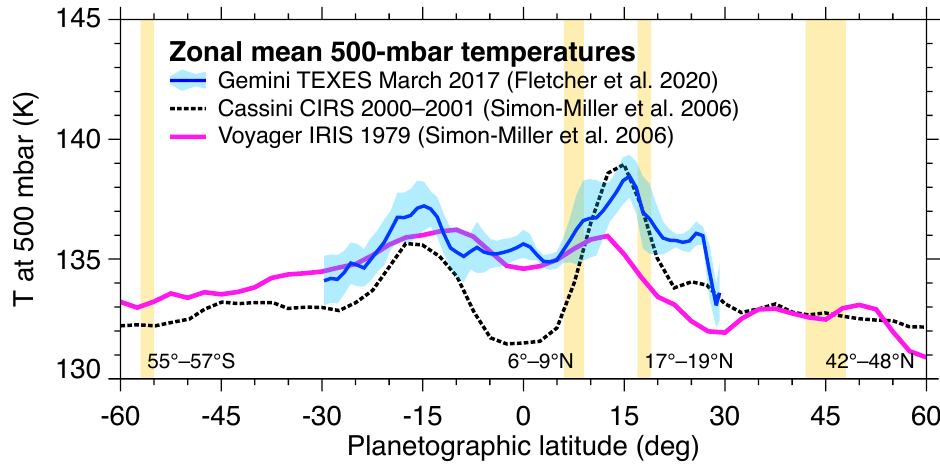
Figure 21. Independent measurements of the zonal-mean temperature field at the 500-mbar level show consistent trends of high temperatures over the equatorial belts, gradually decreas- ing poleward [122,143]. The EZ temperature was depressed in the Cassini data. Differences between the temperature profiles retrieved from Cassini and Voyager data may be from temporal variability. The Gemini temperature profile is an average of seven separate scans taken over a period of 3 nights, with the standard deviation (shaded) giving a sense of longitudinal and short-timescale temporal variability. Shaded yellow bars (with latitude ranges given) indicate locations where deep cloud tops at 5–7 bar were retrieved from 5-µm spectroscopic data [11]: high-latitude folded filamentary regions (FFRs) near 56 ◦ S and 45 ◦ N, a pair of cyclonic vortices in the NEB near 18 ◦ N, and deep clouds near 8 ◦ N associated with ammonia plumes [40] in the upwelling branch of the NEB Rossby-wave system that maintains 5-micron hotspots in the downwelling branch [25,139,140]. The full range of temperatures in each yellow bar defines the height of the “cloud boxes” defined in Figure